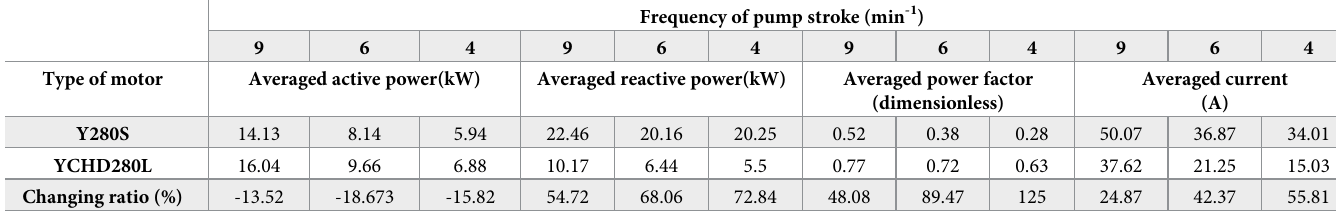
Table 4. Comparison of test electrical parameters of two